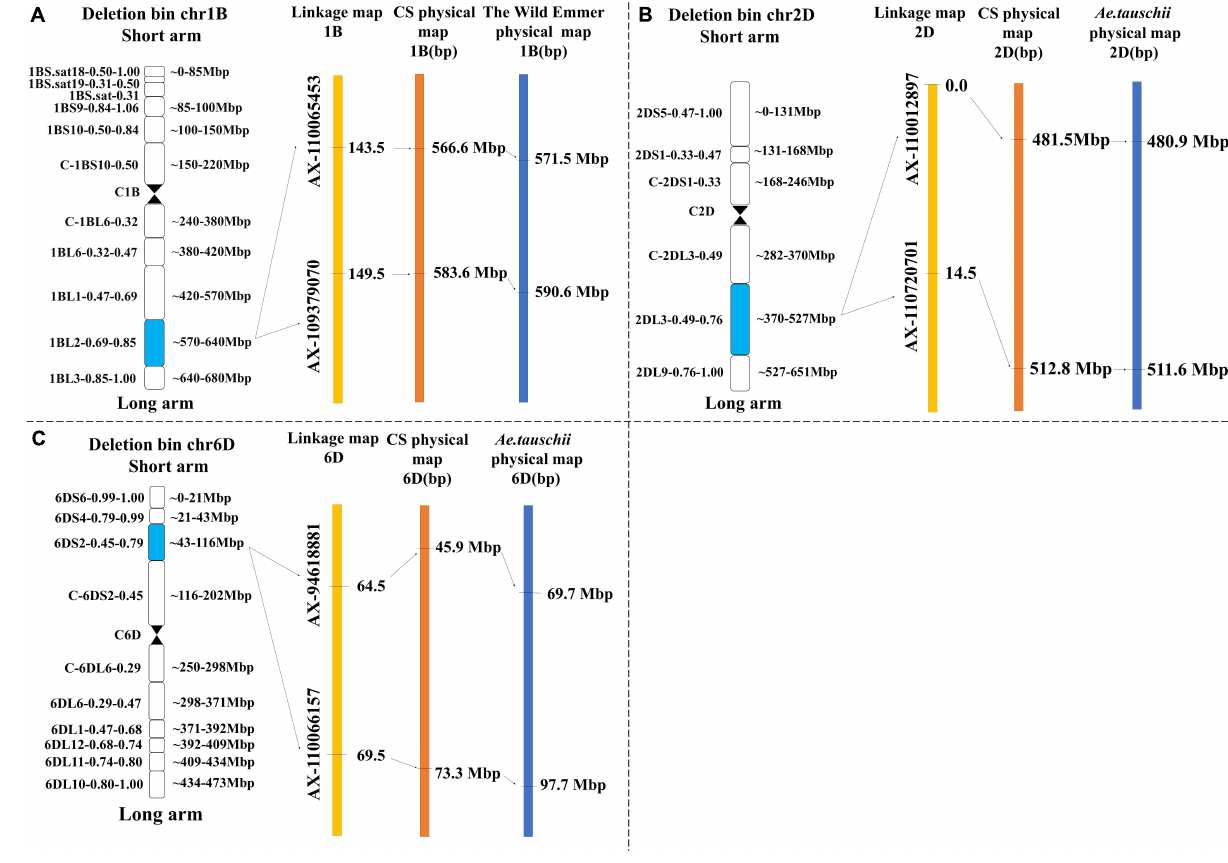
FIGURE 6 | Genetic and physical maps of the four major QTLs in the target interval on Chinese spring, T. turgidum and A. tauschii reference genomes (“ A ” represents QKL.sicau-2SY-1B and QKS.sicau-2SY-1B ; “ B ” represents QKT.sicau-2SY-2D , QTKW.sicau-2SY-2D , QKS.sicau-2SY-2D , and QFFD.sicau-2SY-2D ; and “ C ” represents QKW.sicau-2SY-6D , QLWR.sicau-2SY-6D , and QKS.sicau-2SY-6D